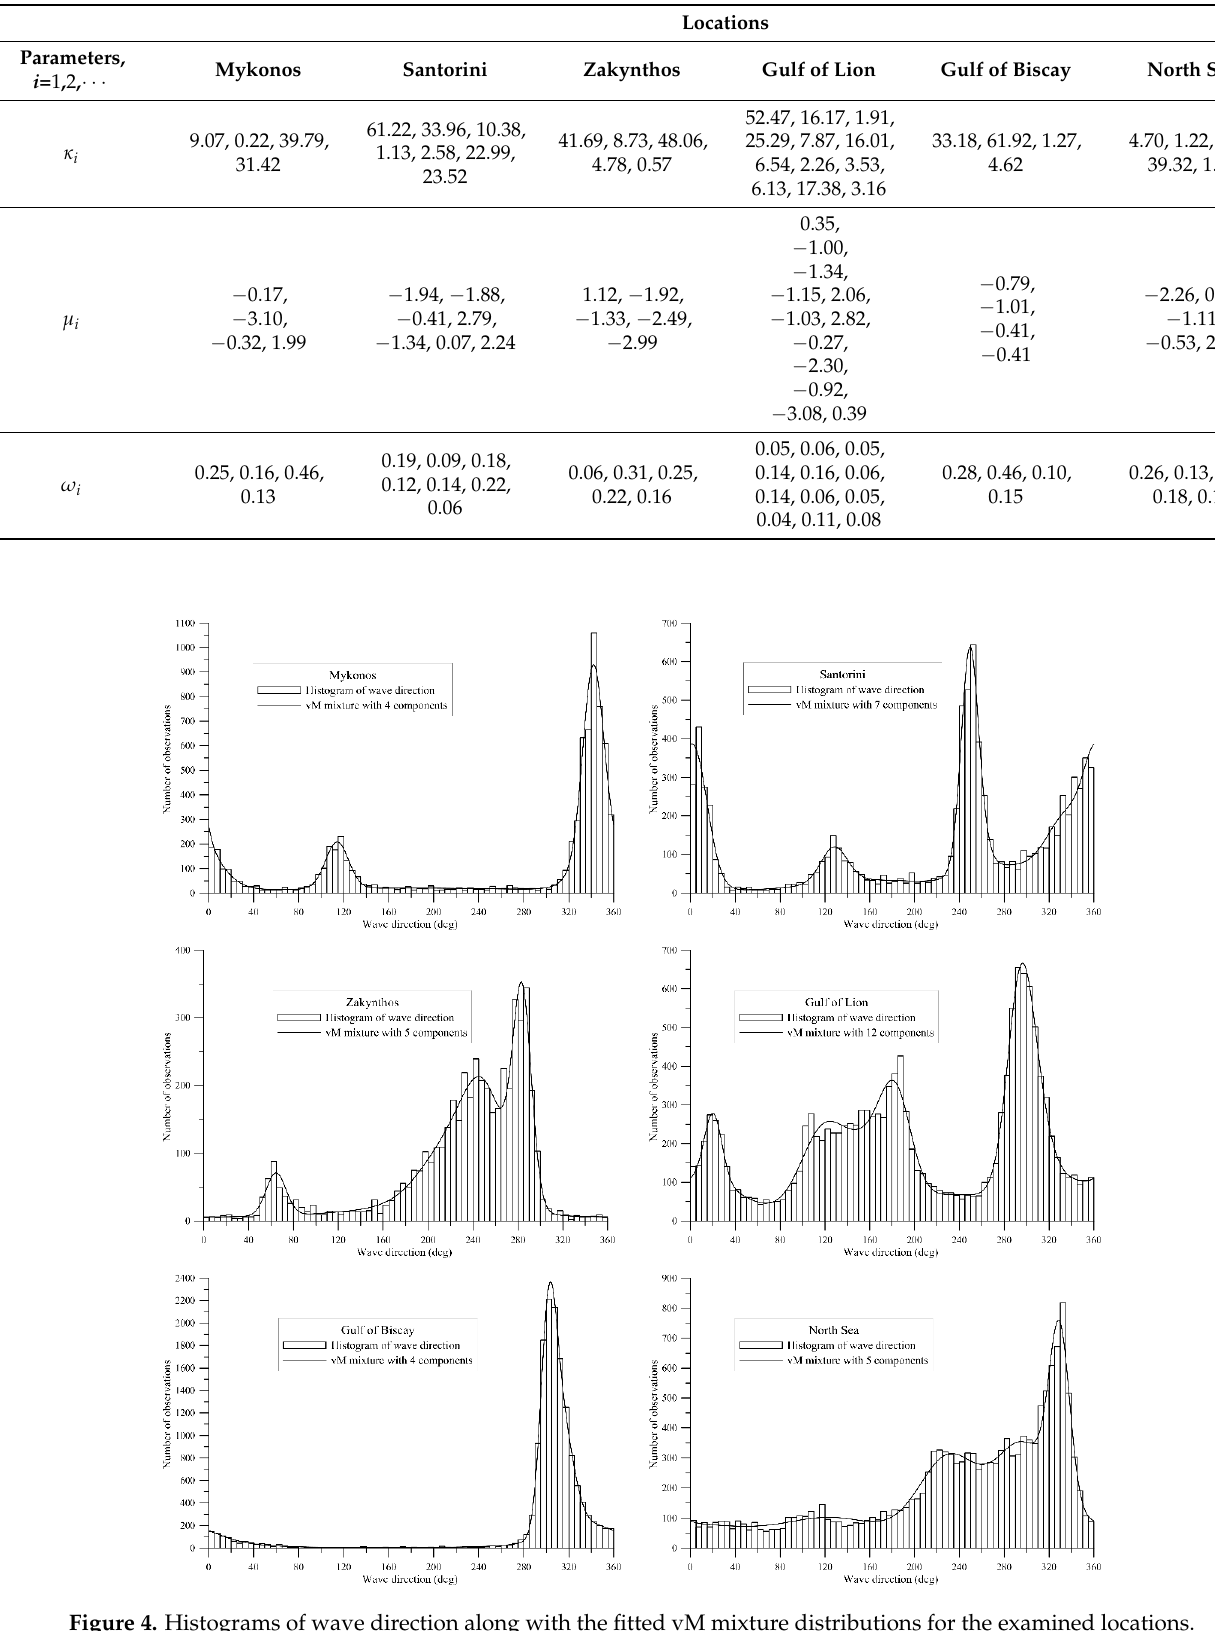
Table 6. Parameters of the best-fit vM mixtures ( κ , µ , ω ) for the examined locations.